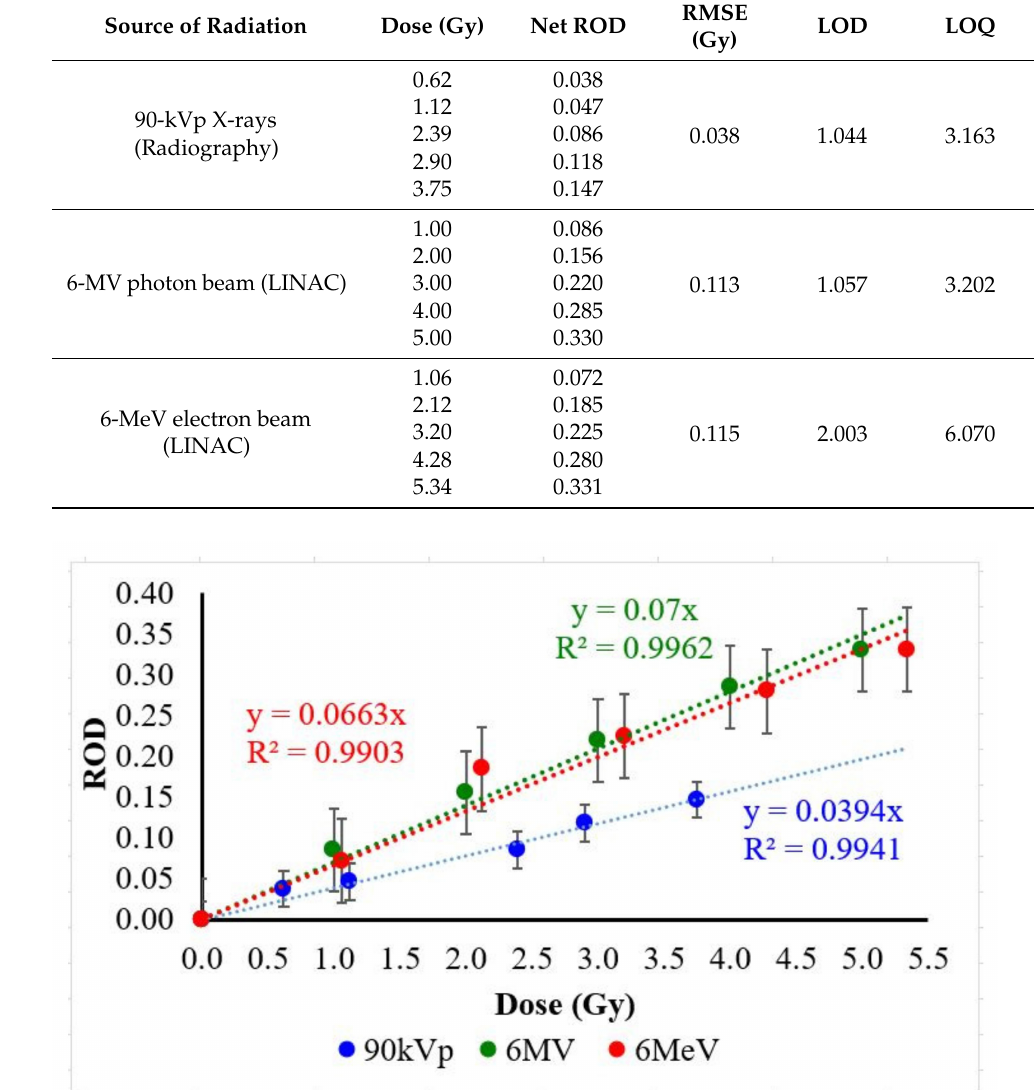
Figure 4. Dose response of expired EBT3 films irradiated with 90-kVp X-rays, 6-MV photon beam, and 6-MeV electron